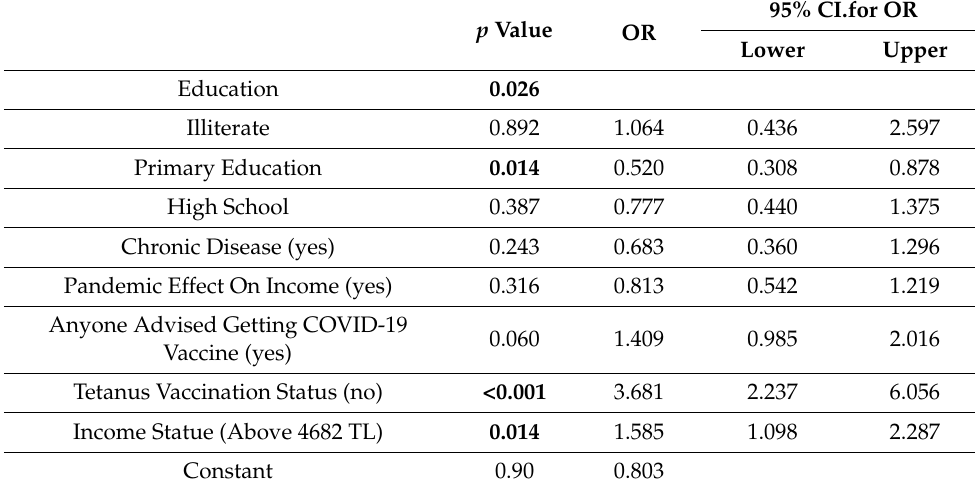
Table 3. Multivariate analysis of variables